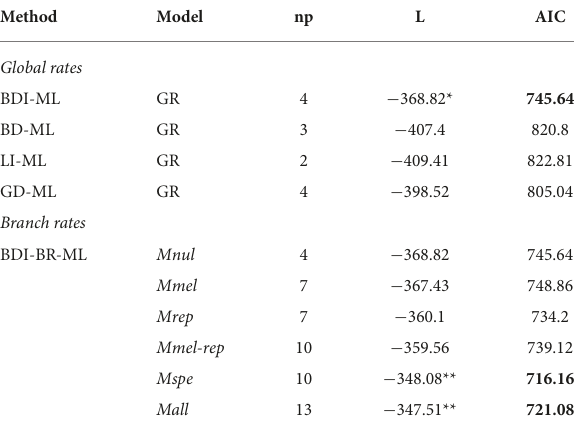
TABLE 3 Likelihood and AIC values for the birth-death-innovation (BDI), birth-death (BD), lambda-innovation (LI), and gain-death (GD) models assuming global (GR) or branch-specific rates (BR), and with maximum likelihood (ML)